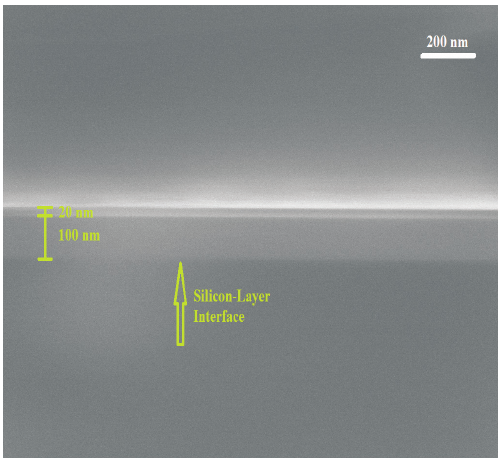
Scanning electron microscope (SEM) image of a bilayer consisting of a 100 nm-thick ALD-TiO and a 20 nm-thick ALD-Al 2